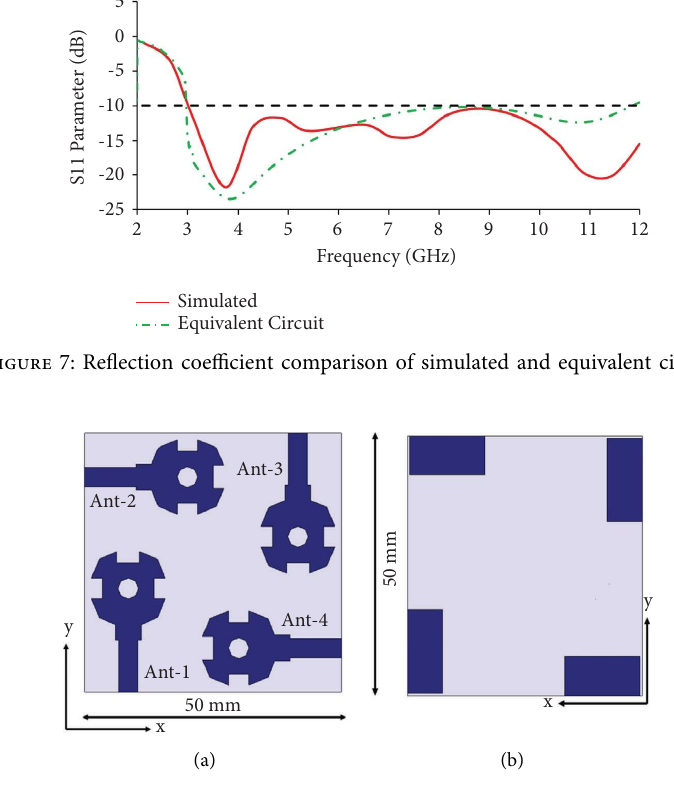
Figure 8: Layout of the MIMO antenna: (a) radiator and (b) ground plane.